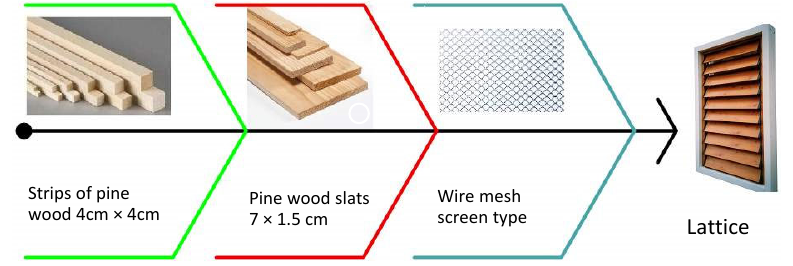
Figure 9. Materials for the design of a lattice prototype.